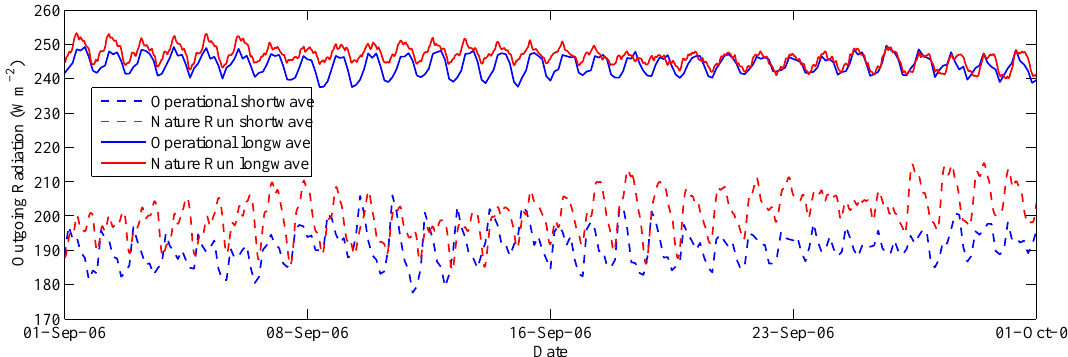
Figure 3. Comparison of longwave and shortwave outgoing radiation for the Nature Run and operational GEOS-5. The time series shows the month of September